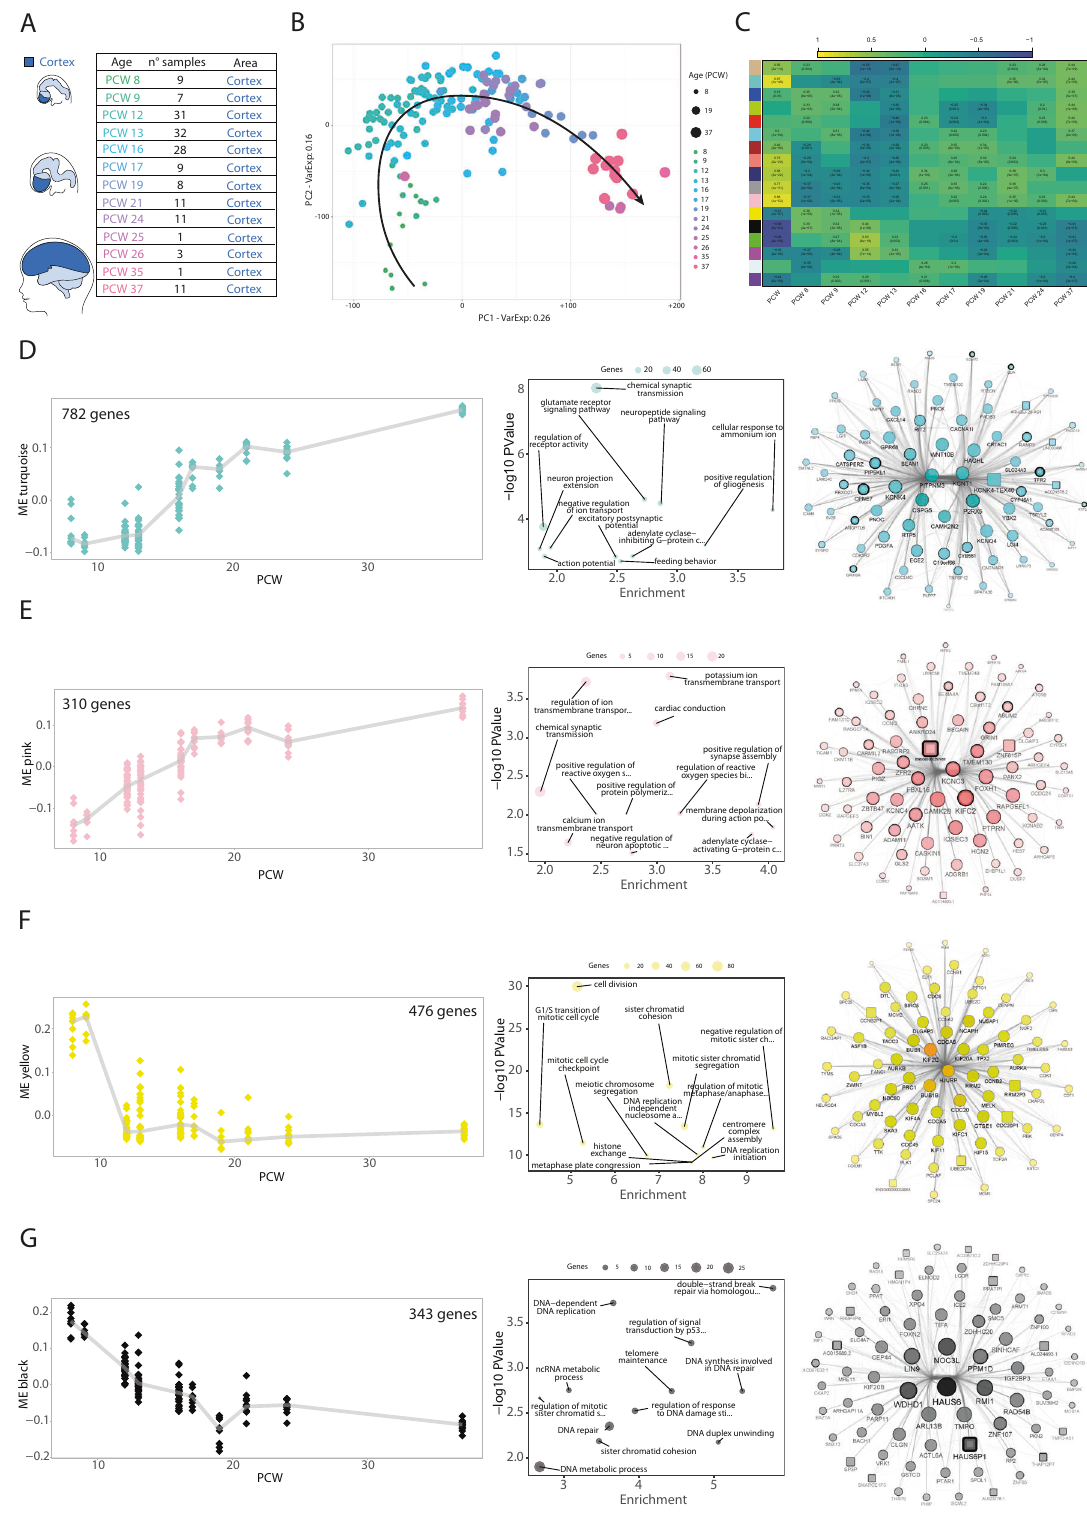
spatial similarity maps of BO against reference were generated to assess organoid engineering protocols and to annotate cell fates [13]. Further detail emerged from integrative analyses showing an overexpression of extracellular matrix (ECM)-related genes in BO associated with the fi rst steps of differentiation in 2D [14], a higher vulnerability to cellular stress in some organoid cultures compared